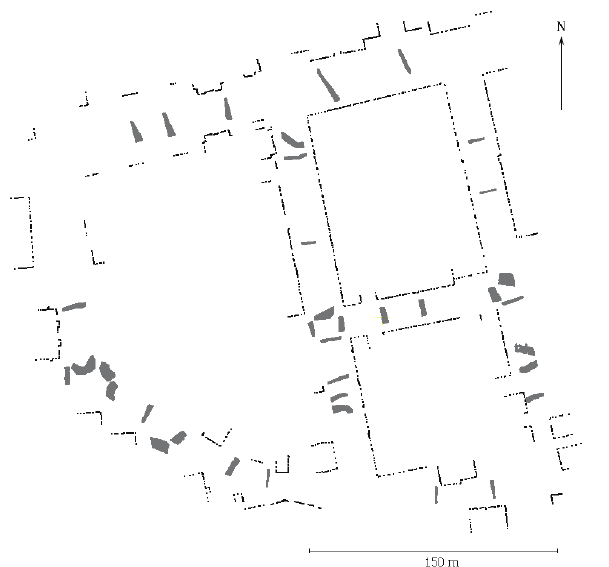
Figure 3. 3D test field with measured points on facades (black) and street profile measurements